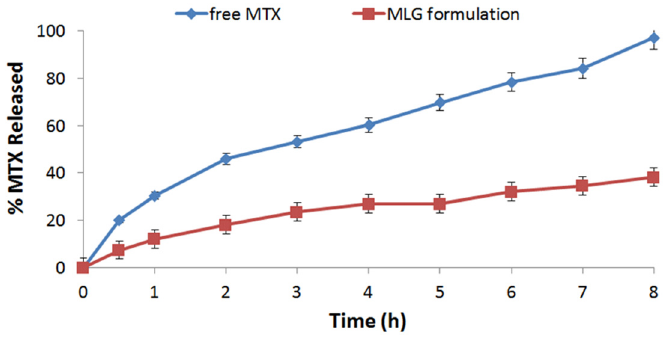
Figure 1. In vitro release profile of MXT from free MXT and MLG formulations ( n = 3 ± SD).